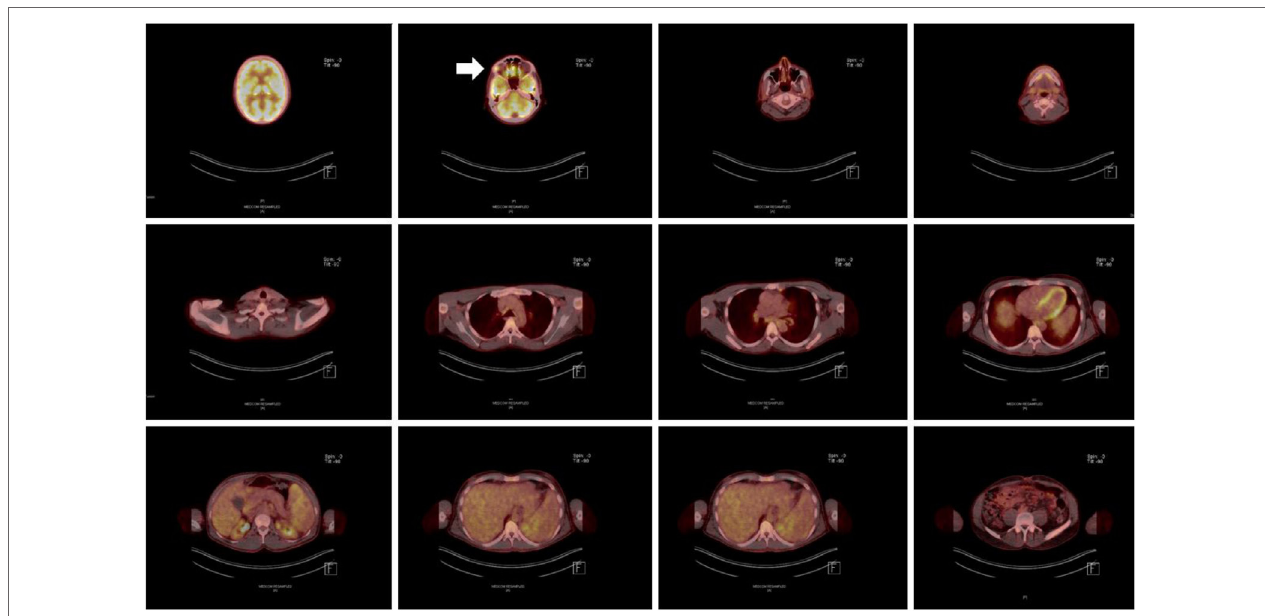
FIgURe 3 | Positron emission tomography/computer tomography scan after completion of an 18-month antimycobacterial therapy, including a 6-month 6-drug regimen, revealing significant homogenous hypermetabolism in the area of the right lacrimal gland (marked with an arrow).